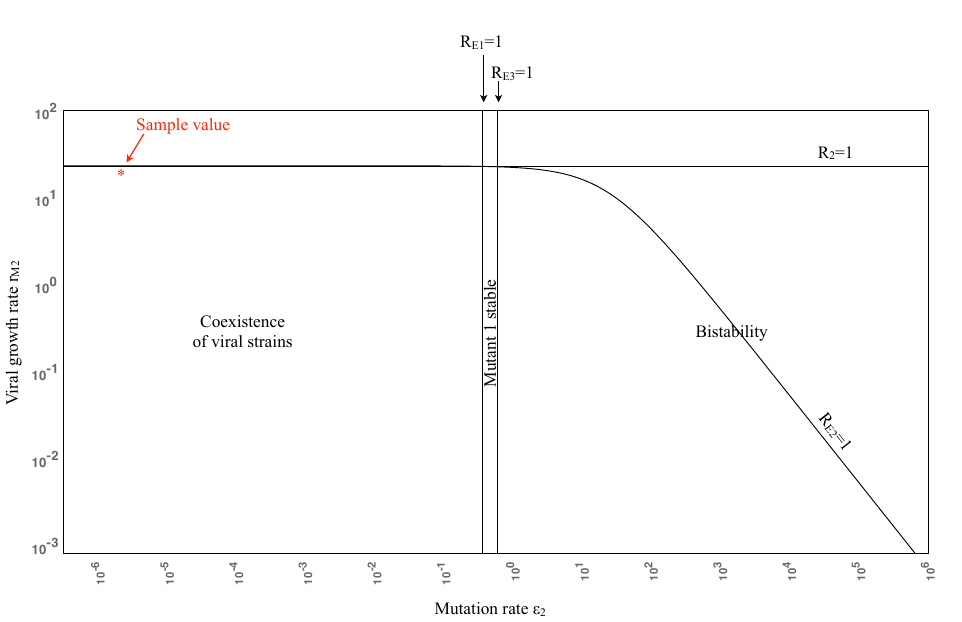
Figure 1. Viral persistence landscape diagram as Mutant 2 varies, showing that an increase in the mutation rate of Mutant 2 can stabilize the Mutant 1 equilibrium. The bistability region is included for completeness, but corresponds to unreasonably high mutation rates. Note the log scale on the